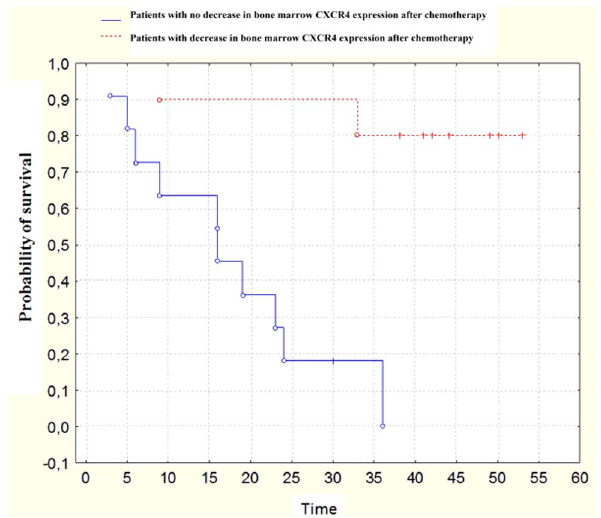
Figure 3. The cumulative proportion of patients’ survival. Kaplan-Meier survival of B-NHL patients with the following levels of CXCR4 expression in bone marrow after treatment: there was no decrease 2 blue line, there was a decrease of CXCR4 expression 2 red dashed.